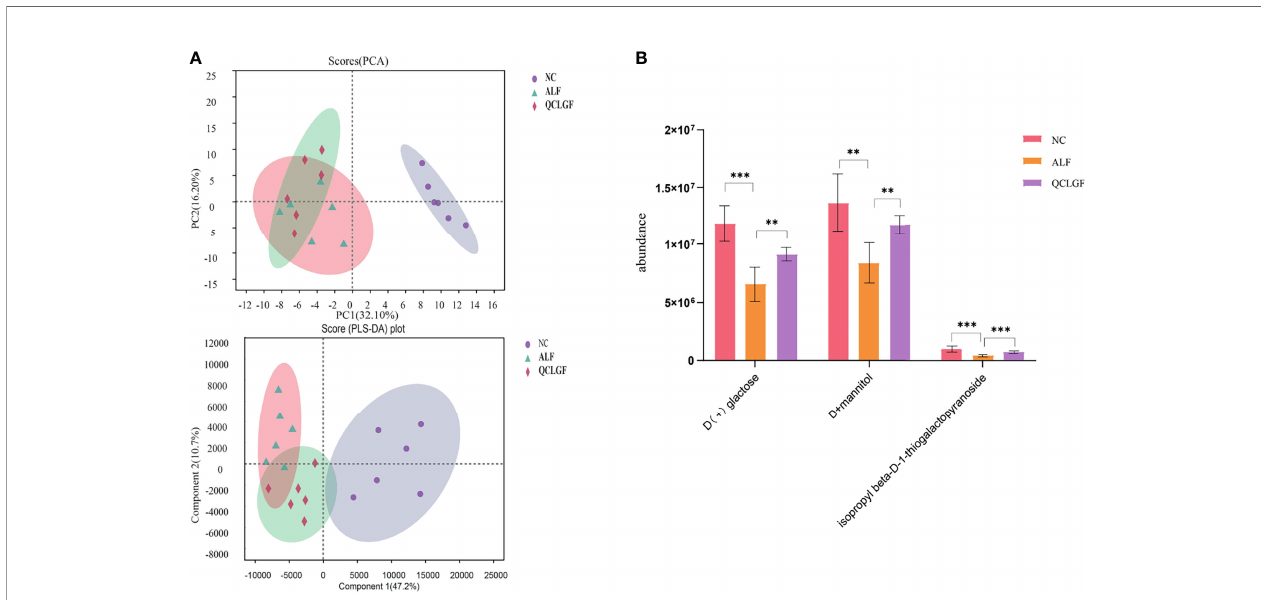
FIGURE 3 | QCLGF protects against D-galactosamine-induced altered plasma metabolites. (A) Changes in the ion intensity of three markers with beta-D-1- thiogalactopyranoside, D(+)galactose, and D-mannitol (t-test, ** P adj < 0.01,*** P adj < 0.05). (B) Principal component analysis (PCA) (PC1 = 32.1%). And the partial least squared discriminant analysis (PLS-DA) score plot based on GC-MS pro fi ling data of plasma samples (compound1 = 47.2%). Each dot with three kinds of color represents the different samples.